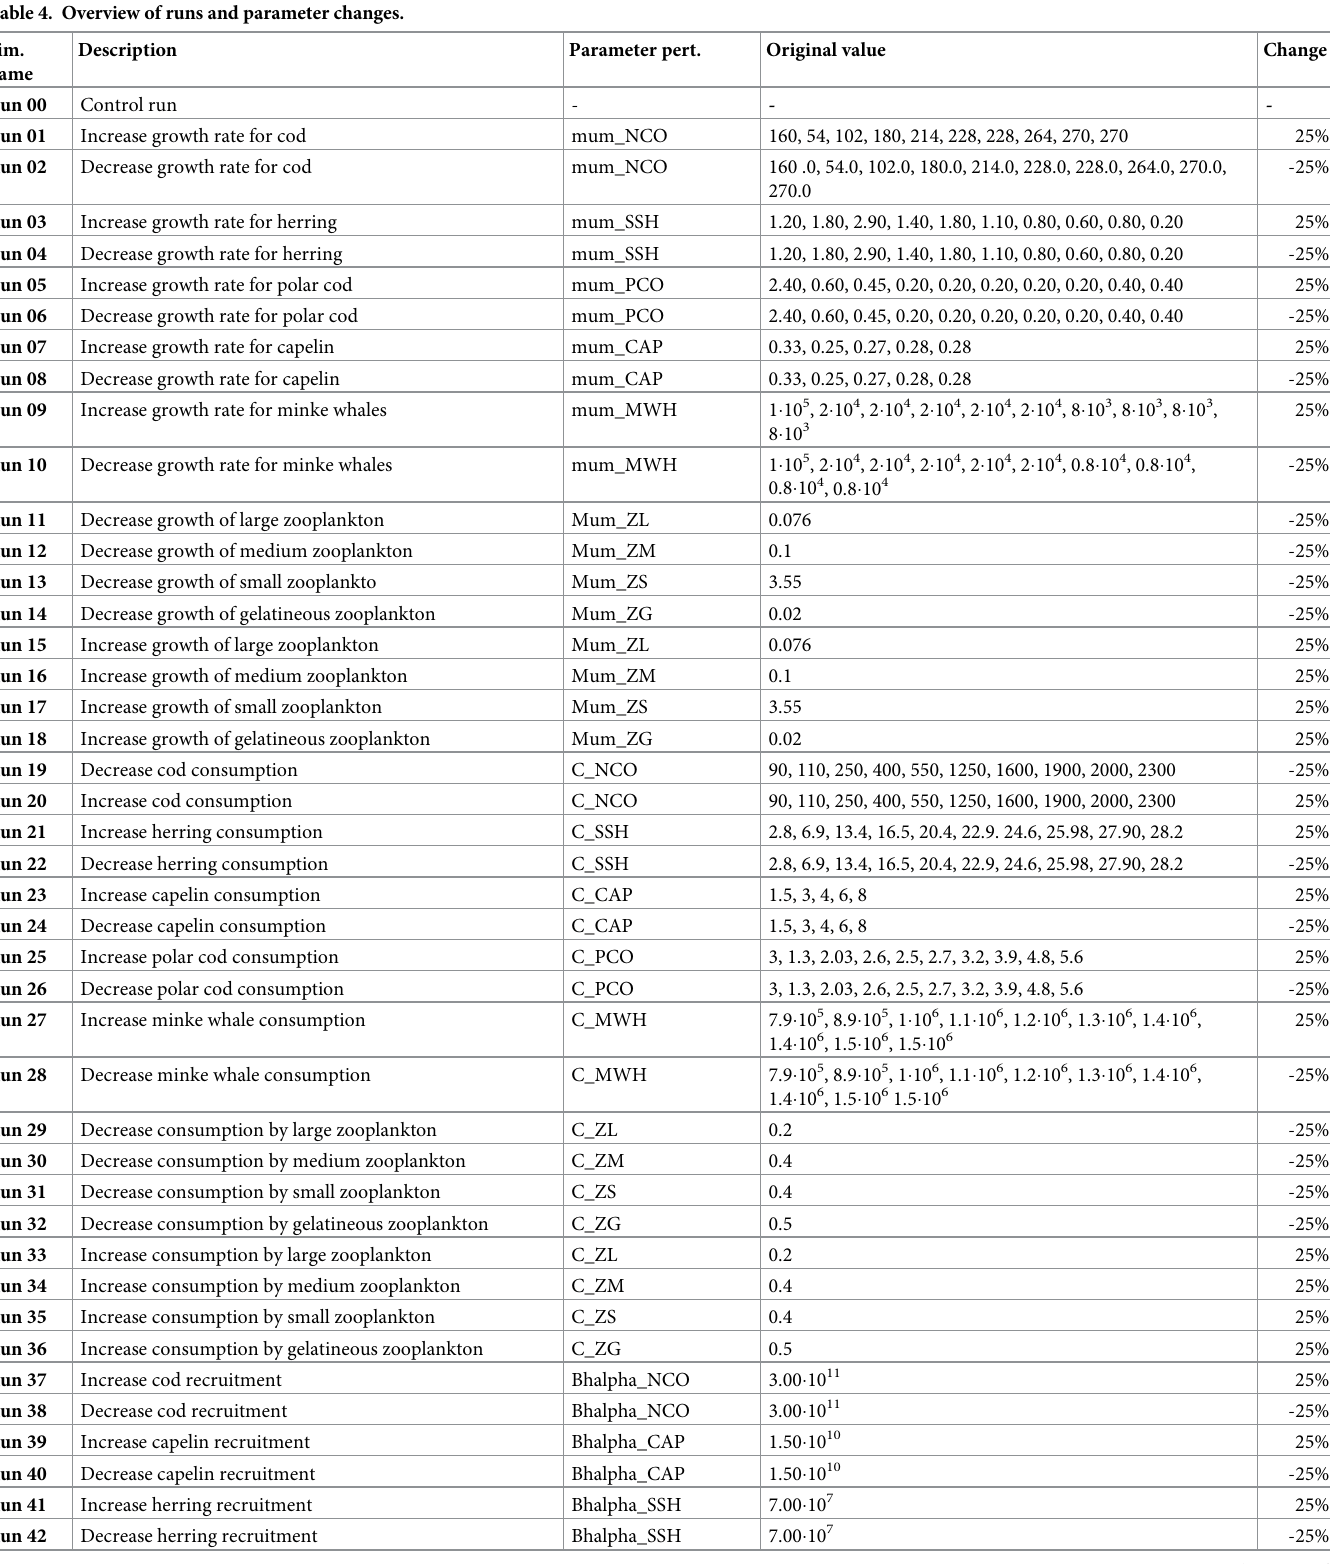
Table 4. Overview of runs and parameter changes. Sim.